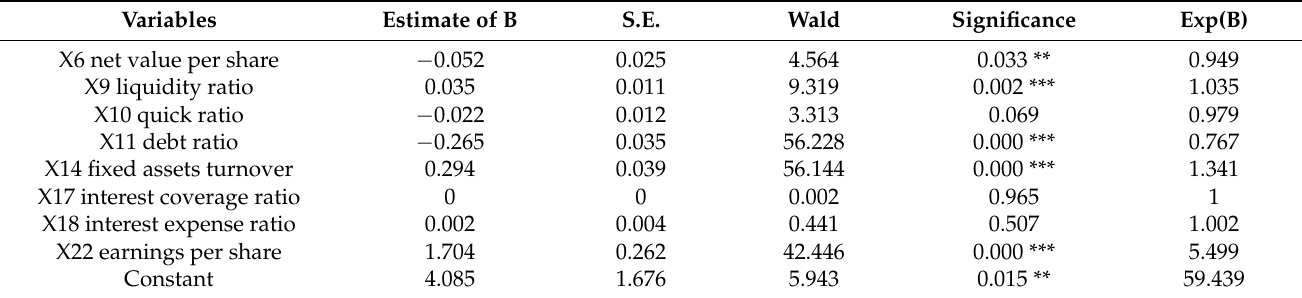
Table 19. Significance values of feature selection variables of 2455 normal and 491 bankrupt companies (5:1) in LR.